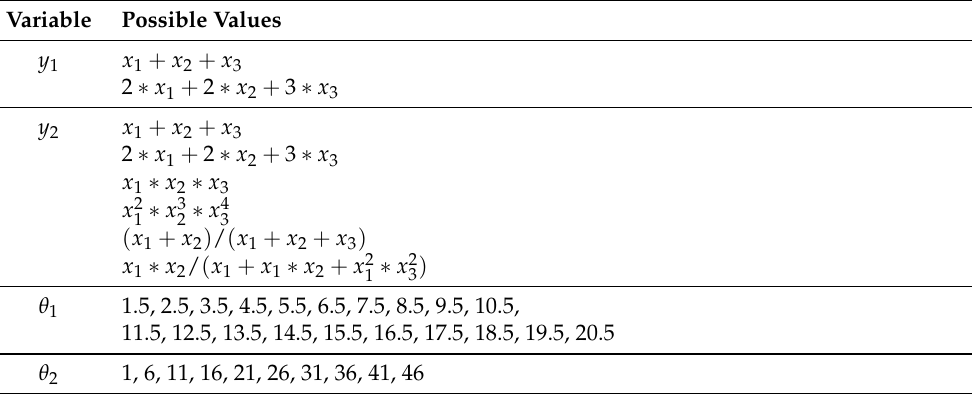
Table 1. Details of the scope of the simulation, describing all possible values for each variable. Variable